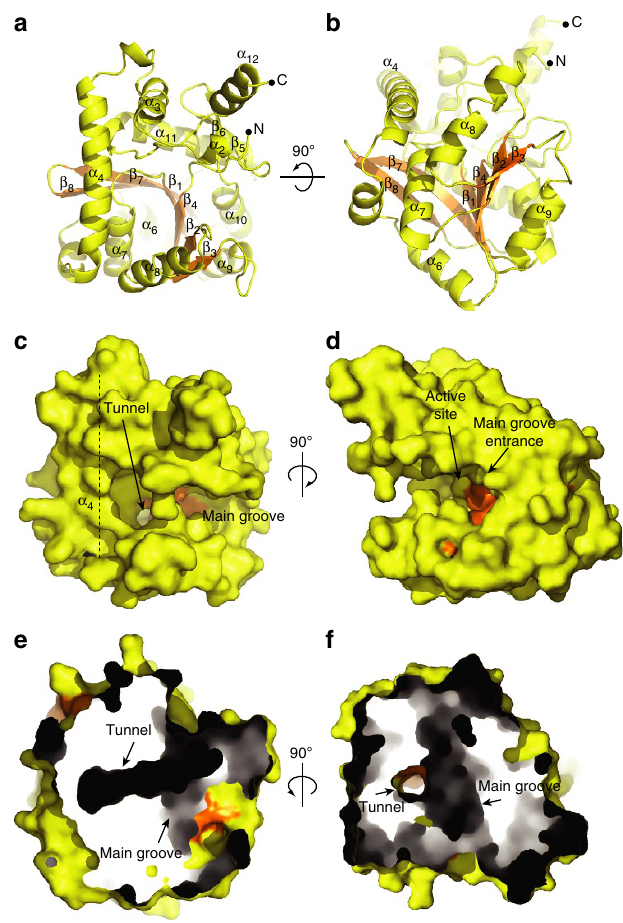
Figure 2 | Overall structure of PatA. ( a , b ) Cartoon representation showing the general fold and secondary structure organization of PatA. Secondary structure elements are labelled. The central core b -sheet is shown in orange. ( c , d ) Surface representation of PatA showing the location of the main groove and the active site. The groove entrance is flanked by two important a -helices, a 11 – a 12 . The groove ends up into a cavity mainly flanked by a 4 . ( e , f ) The main groove runs perpendicular to a hydrophobic tunnel, which is deeply buried into the core of